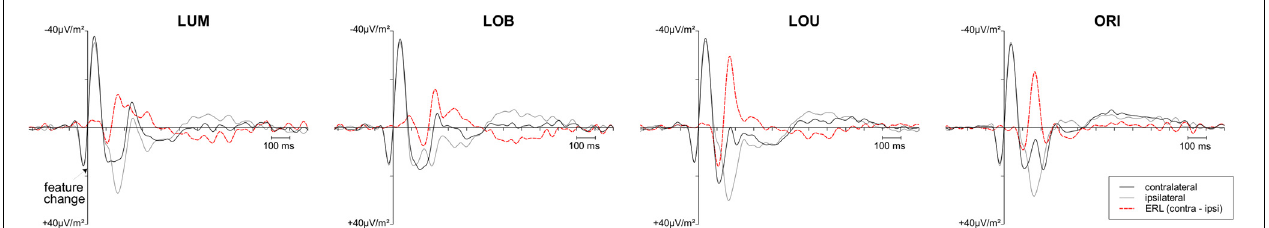
FIGURE 4 | Grand average posterior ERPs (PO7/PO8) contralateral and ipsilateral to the feature change. In case of the luminance change conditions (LUM, LOB, LOU), the black curve represents the activation contralateral to the luminance change. For the ORI condition, the black curve represents the activation contralateral to the orientation change. The ERL